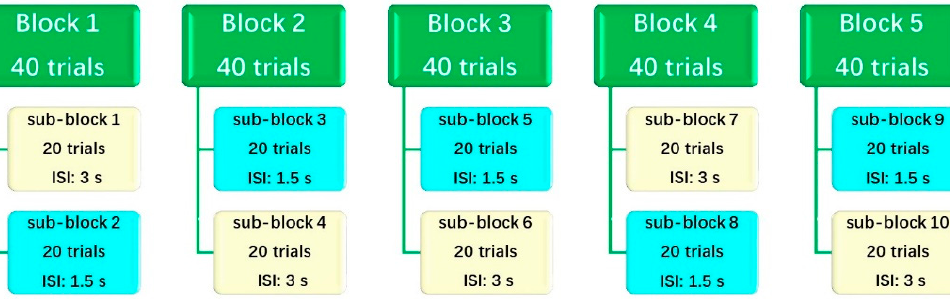
Figure 2. The structure of K-CPT.